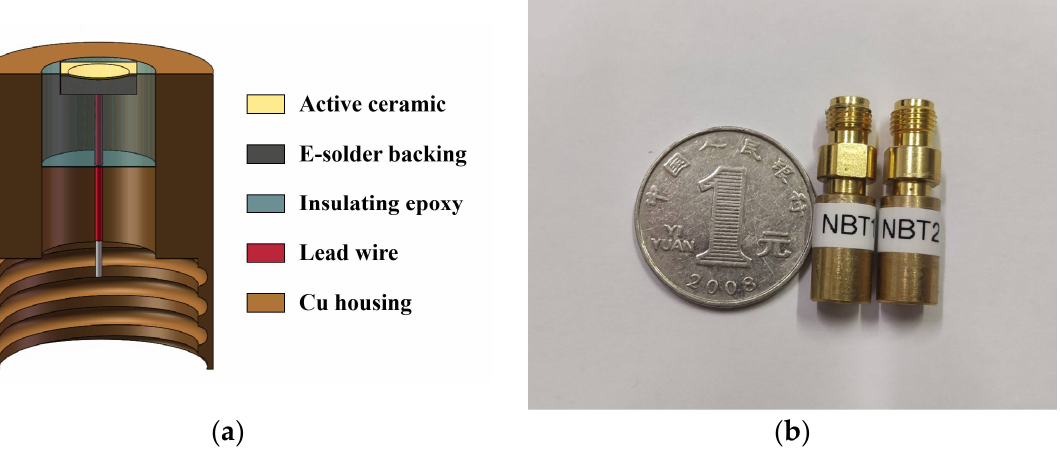
Figure 5. ( a ) Schematic diagram of the internal structure of the transducer; ( b ) end product image of the finished transducer.